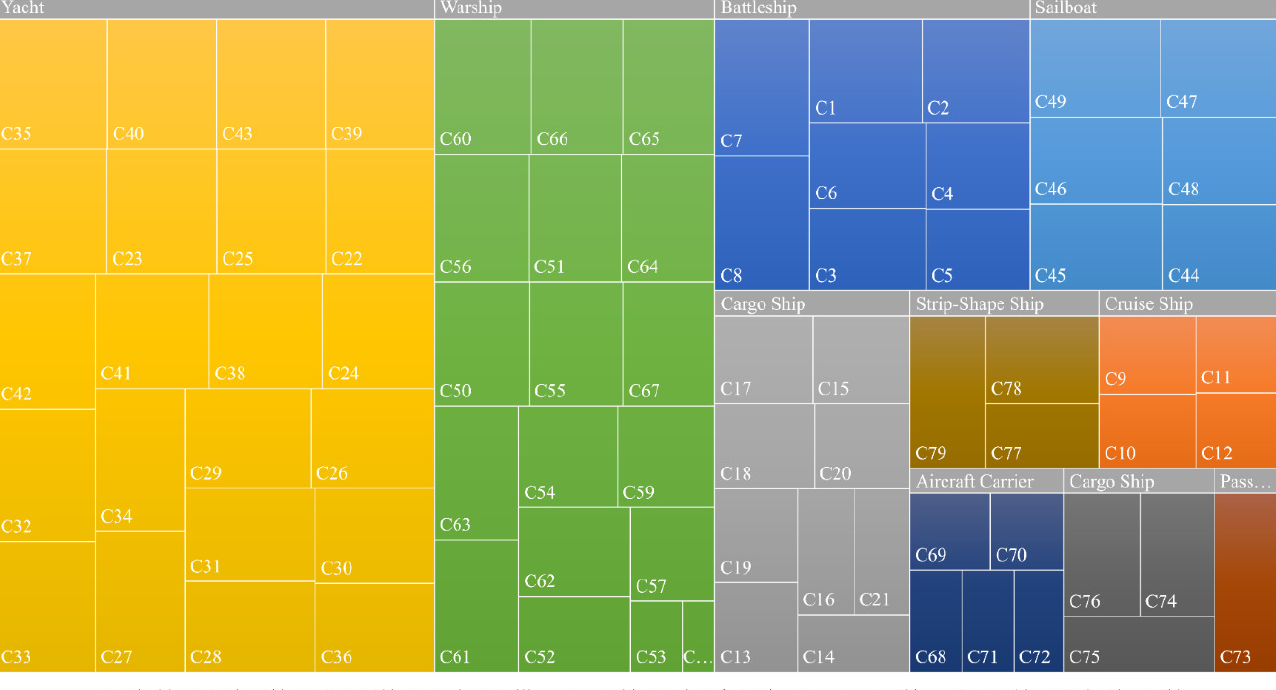
Figure 6. Area distribution map of ship instances. Different colors represent different categories, and the sizes of areas represent the number of ship instances in each category.